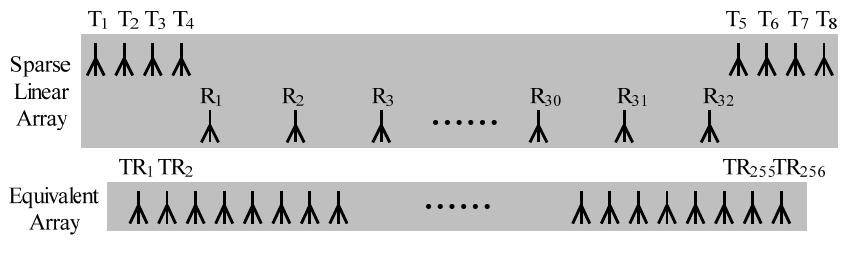
Figure 8. DLSLA 3-D SAR sparse array configuration.